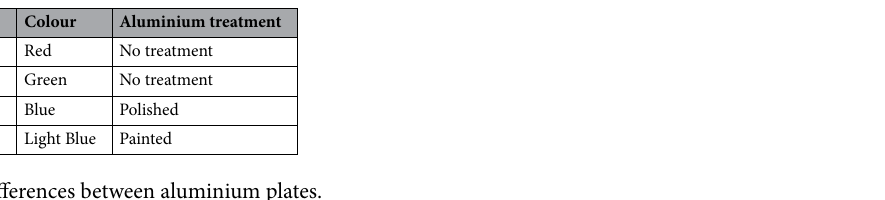
Table 1. Differences between aluminium plates.